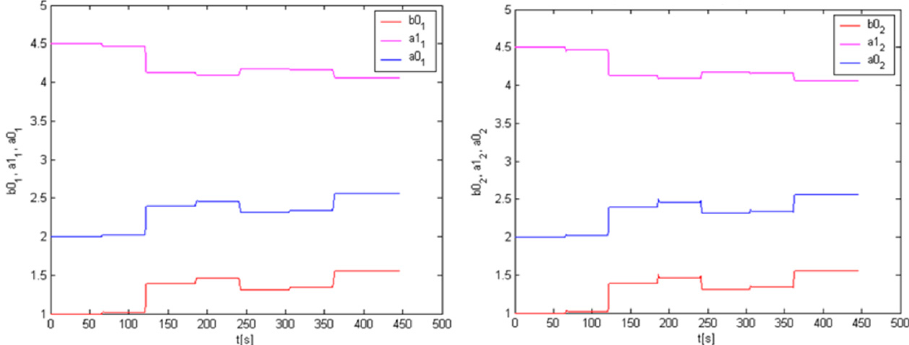
Figure 6. System pre-identification using recursive intrumental variable—1st subsystem ( left ), 2nd ( right ).